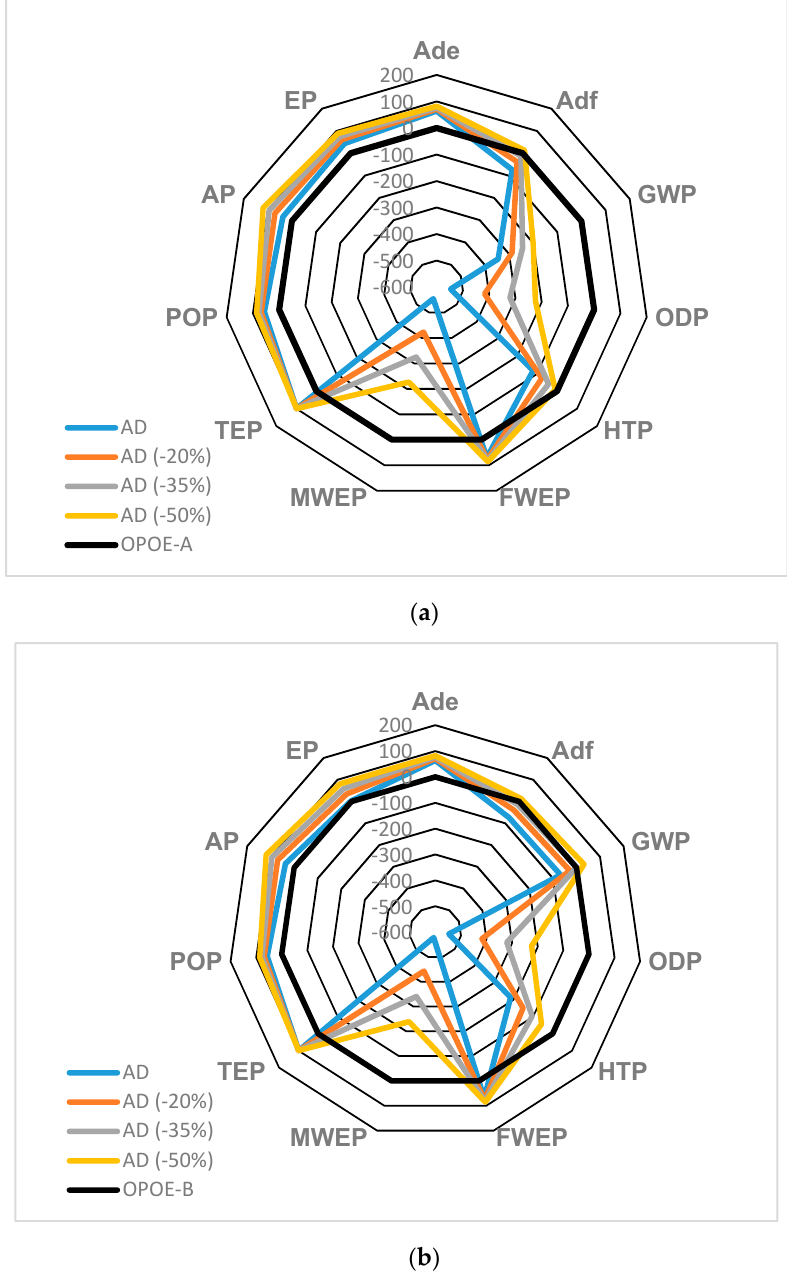
Figure 7. Influence of the reduction of the biogas production from olive mill solid waste in the anaerobic digestion (AD) on the environmental LCA (life cycle assessment) comparison with OPOE employing natural gas ( a ) and a fraction of the extracted olive pomace ( b ) as fuel for drying.